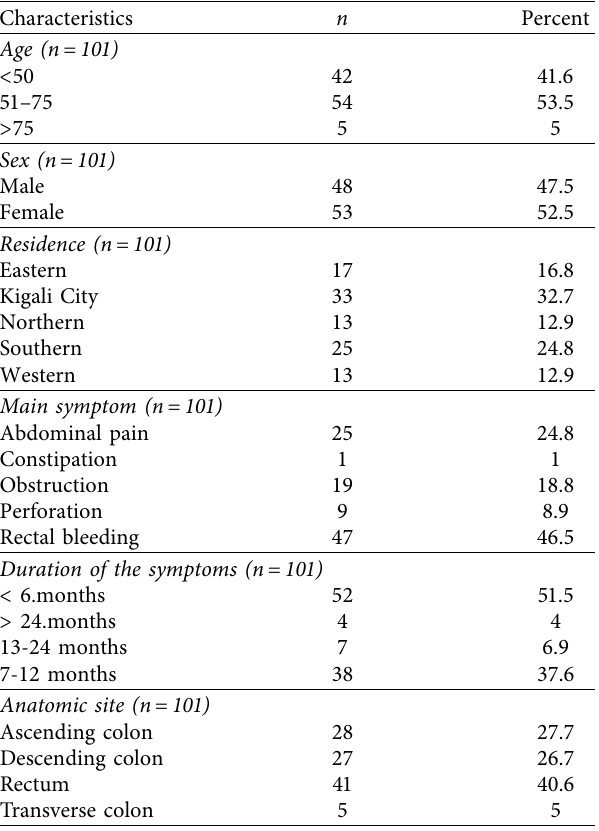
Table 1: Distribution of age, sex, residence, main symptoms, duration of the symptoms, and biopsy site for the study participants.